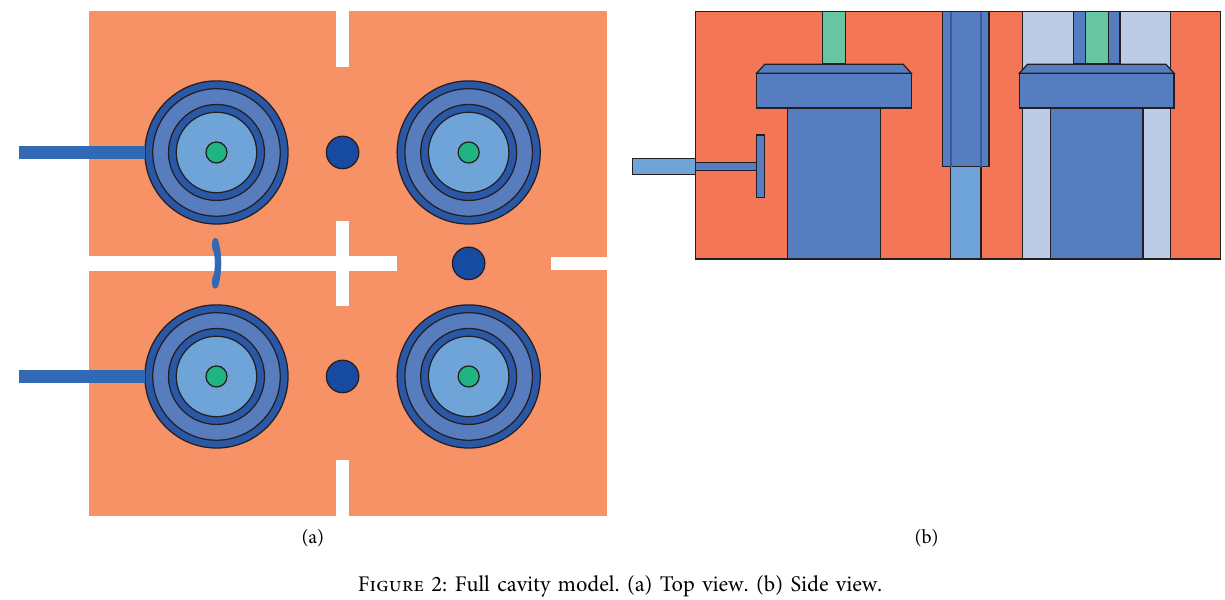
Figure 2: Full cavity model. (a) Top view. (b) Side view.